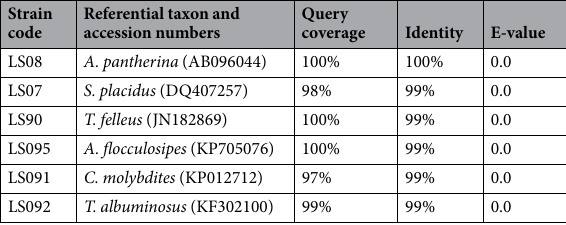
Table 1. The BLAST results of six species